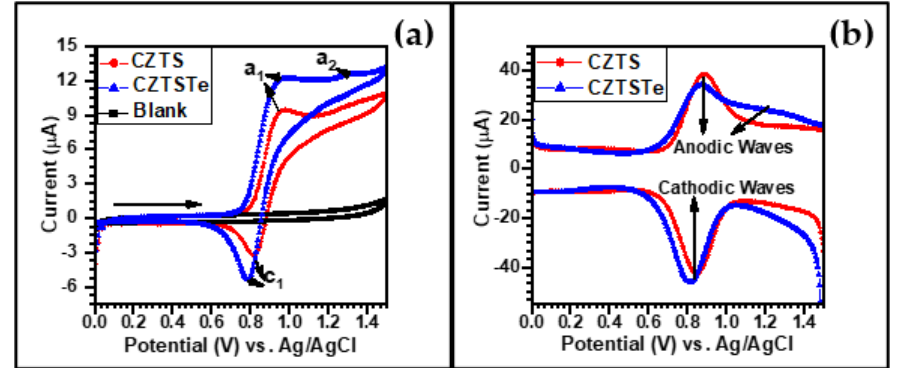
Figure 8. ( a ) Cyclic voltammograms obtained at 10 mV s −1 and ( b ) square-wave voltammograms of 4 mM CZTS and 4 mM CZTSTe in 0.1 M lithium perchlorate in